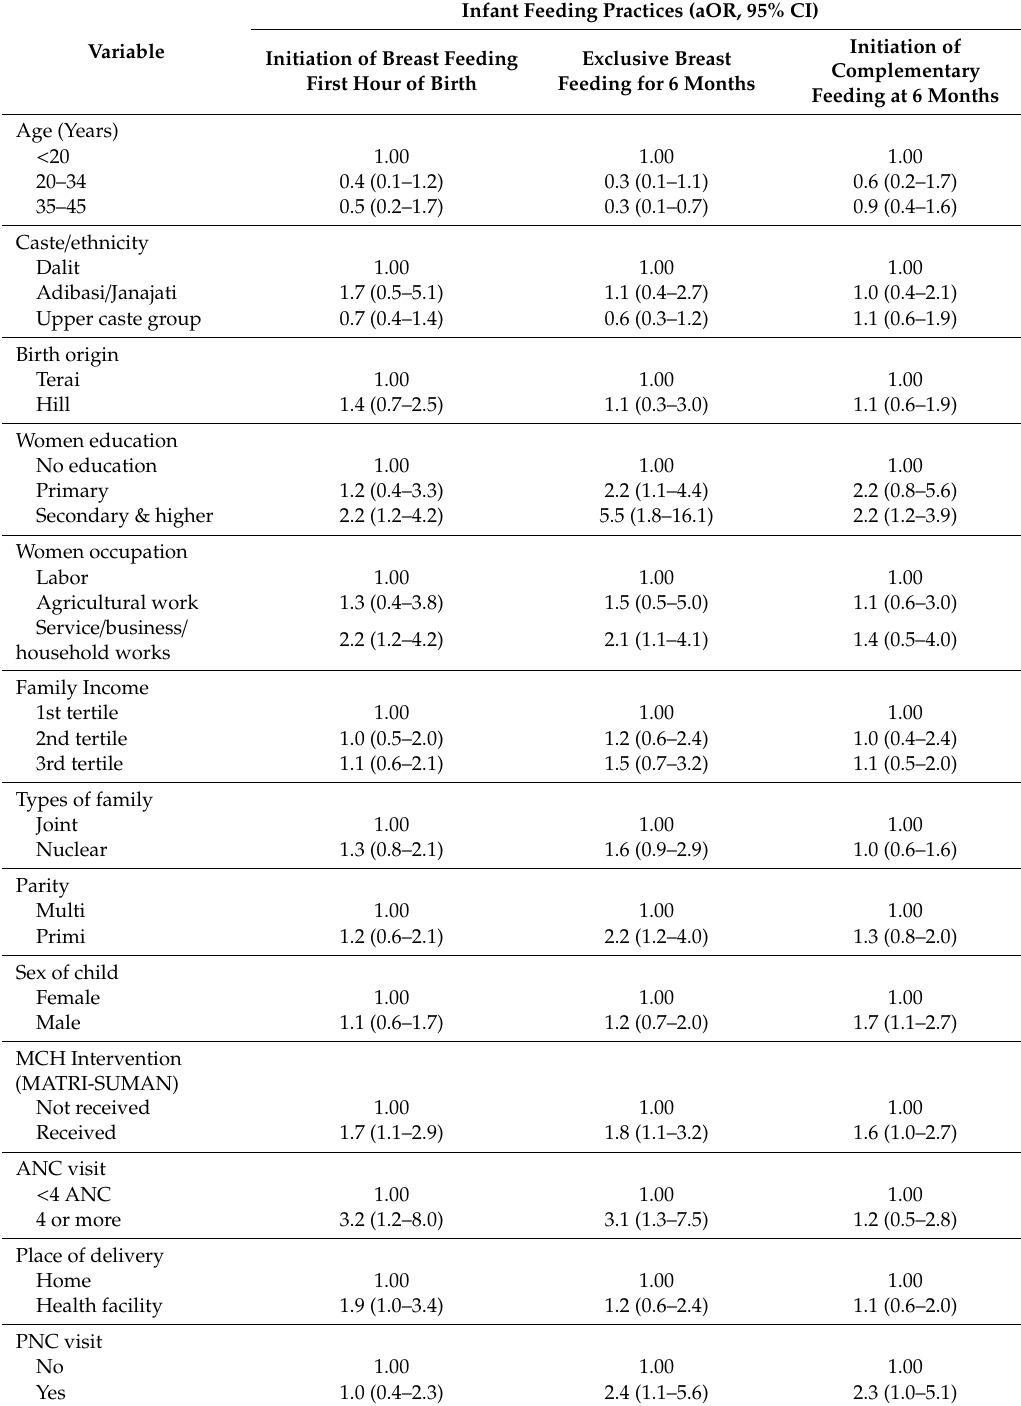
Table 5. Adjusted Odds Ratio (aOR) for infant feeding practices among rural mothers of Southern Nepal, 2016. Infant Feeding Practices (aOR, 95% CI) Initiation of Variable Initiation of Breast Feeding Exclusive Breast First Hour of Birth Feeding for 6 Months